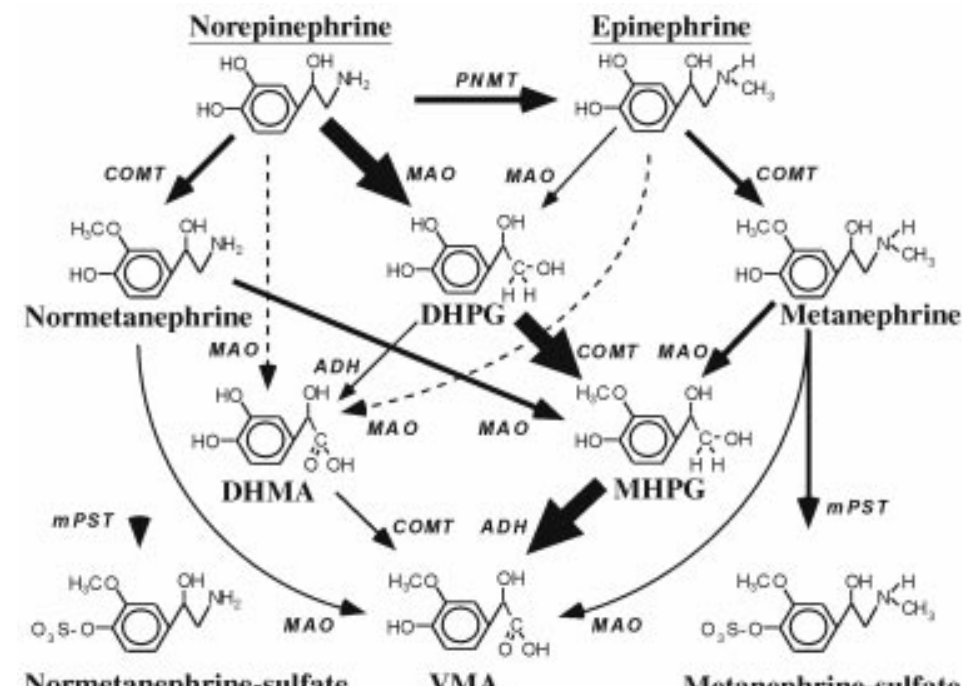
Figure 1 - Pathways of metabo- lism of norepinephrine and epi- nephrine. Enzymes responsible for each pathway are indicated by the arrowheads. The more solid arrows indicate the more major pathways of metabolism while the dotted arrows indicate pathways of negligible impor- tance. Compounds that are rou- tinely measured in urine or plas- ma for diagnosis of pheochro- mocytoma are underlined.